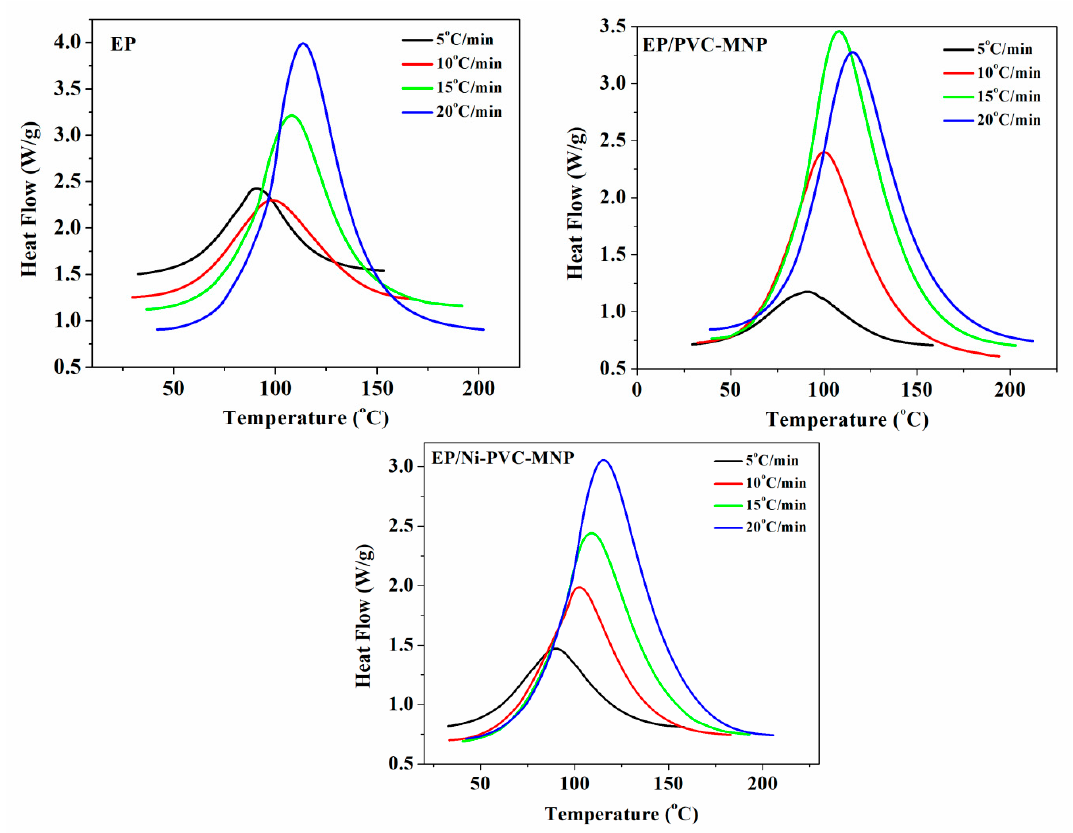
Figure 6. Nonisothermal DSC thermograms of EP, EP / PVC–MNPs [45] and EP / Ni-doped PVC–MNPs at different heating rates.